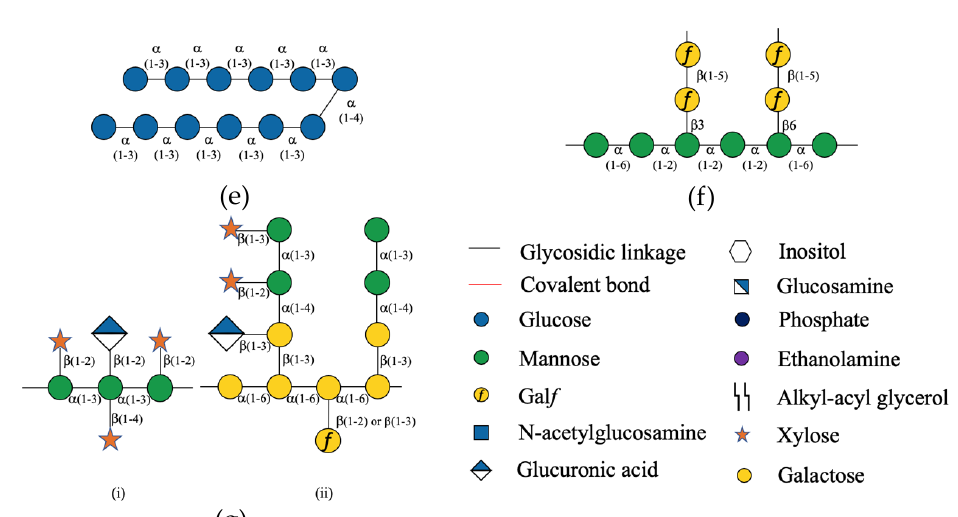
Figure 2. Schematic structure of ( a ) Glycosylphosphatidylinositol (GPI), and common fungal polysaccharides ( b ) β -(1,3)-glucan, ( c ) β -(1,6)-glucan, ( d ) Chitin, ( e ) α -(1,3)-glucan, ( f ) Galactomannan, found in Aspergillus genera, ( g ) (i) Glucuronoxylomannan (GXM), (ii) Galactoxylomannan (GXMGal), found in the capsule of Cryptococcus